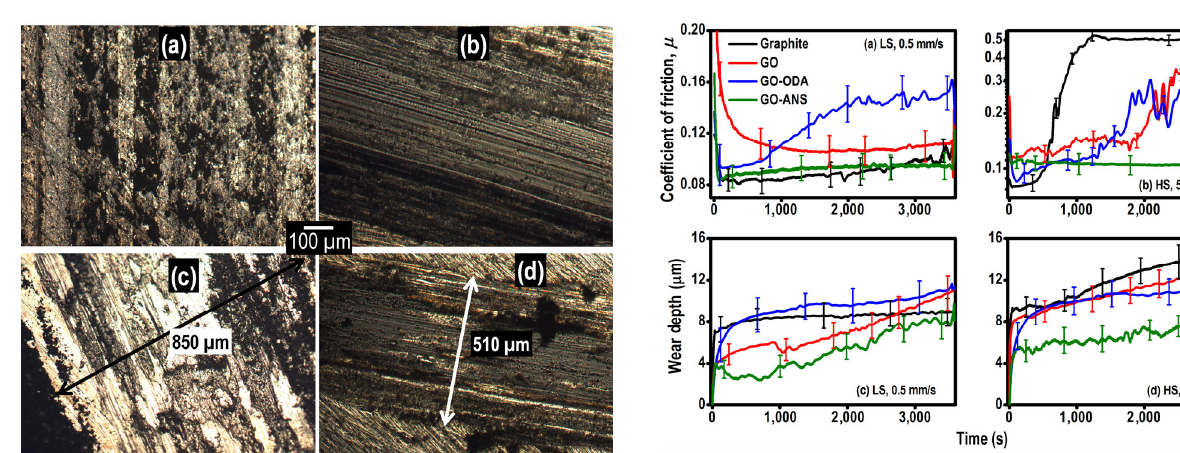
| https://mc03.manuscriptcentral.com/friction